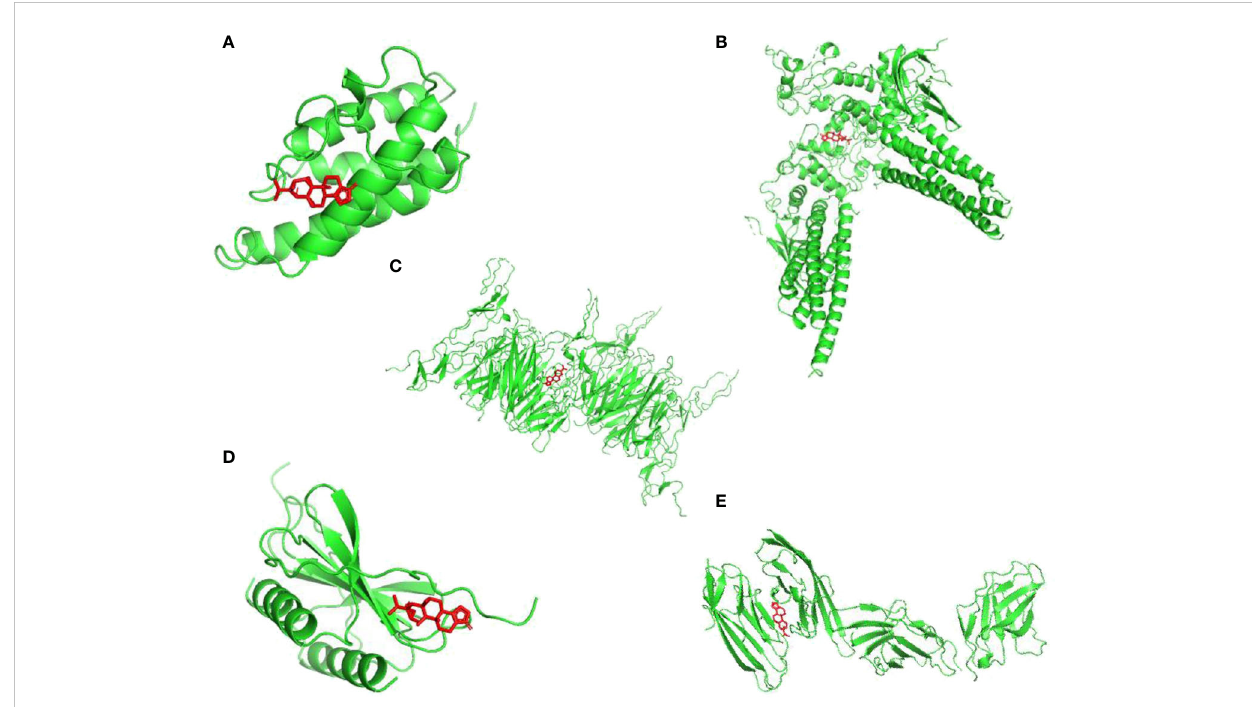
FIGURE 3 Visualizations of the interactions between targets and TPL by molecular docking analysis. (A) IL4; (B) STAT3; (C) CD40; (D) CXCL8; (E) CD86.